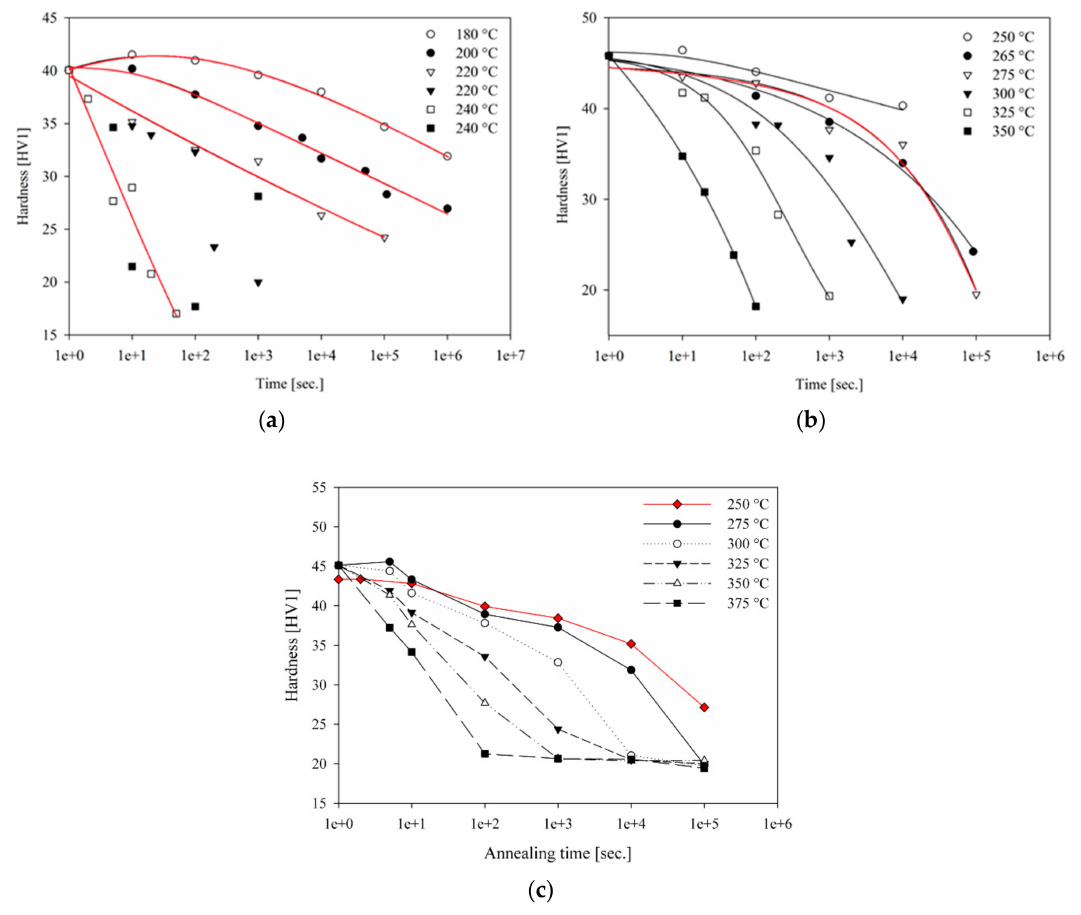
Figure 3. Softening curves of HP Al ( a ), Al-0.25Mn ( b ) and commercial purity CP Al ( c ). Notice both extended recovery and recrystallization at 220 ◦ C and 240 ◦ C for HP Al. The as-deformed state is given at t = 1